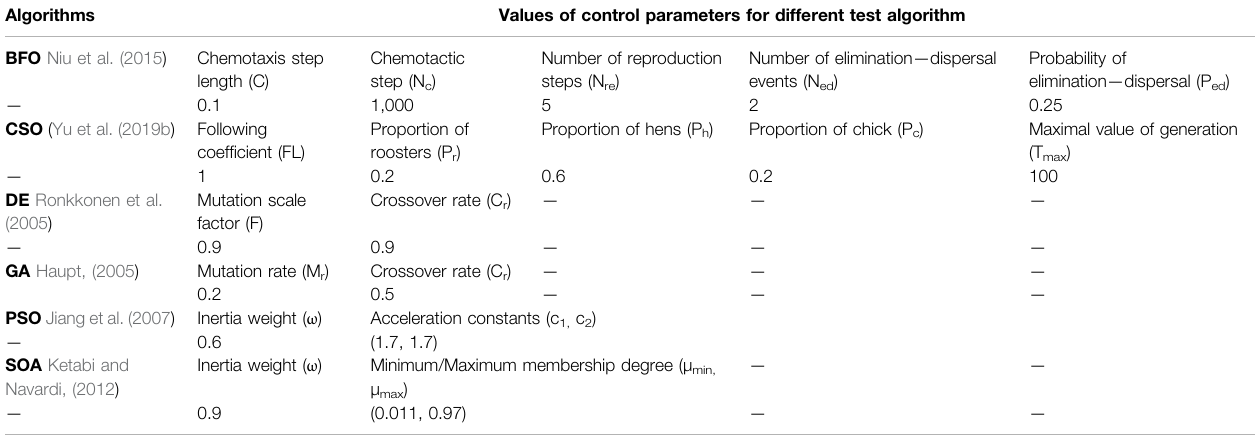
TABLE 2 | Empirical constant values of the remaining control parameters in optimization algorithms.